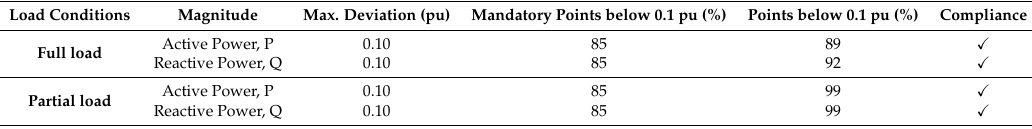
Table 3. Verification of the Procedure for Verification, Validation and Certification (PVVC) validation criteria applied to the manufacturer detailed WT simulation